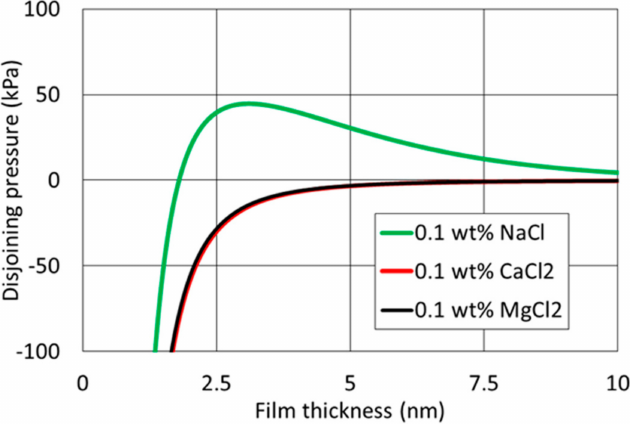
Figure 3. Total disjoining pressure, under constant reduced potential, versus interfacial separation of kaolinite and Oil A with presence of various cation types.